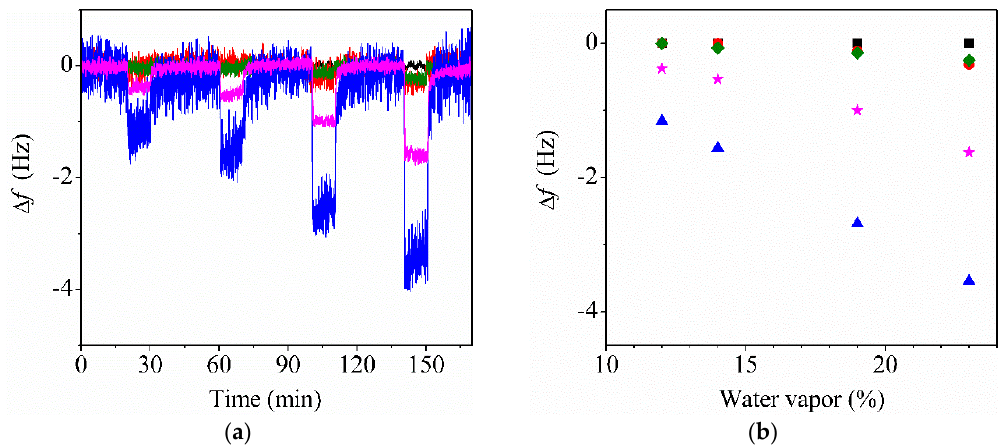
Figure 6. ( a ) Time-dependent changes in the resonance frequency changes of the bare QTF (black), P30-QTF (red), P60-QTF (green), CP30-QTF (blue), and CP60-QTF (pink) upon exposure to water vapor. The relative humidity (RH) was varied sequentially at each of the following measurements: 9%, 12%, 14%, 19%, and 23%. ( b ) Changes in the resonance frequencies of the bare QTF (black square), P30-QTF (red circle), P60-QTF (green diamond), CP30-QTF (blue triangle), and CP60-QTF (pink star) upon exposure to water vapor.